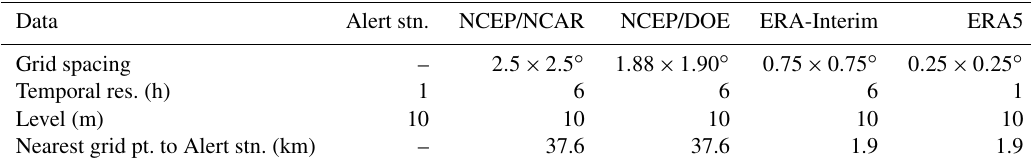
Table 1. Information about the available wind data for the study area from the Arctic Alert weather station and the four sources of reanalysis